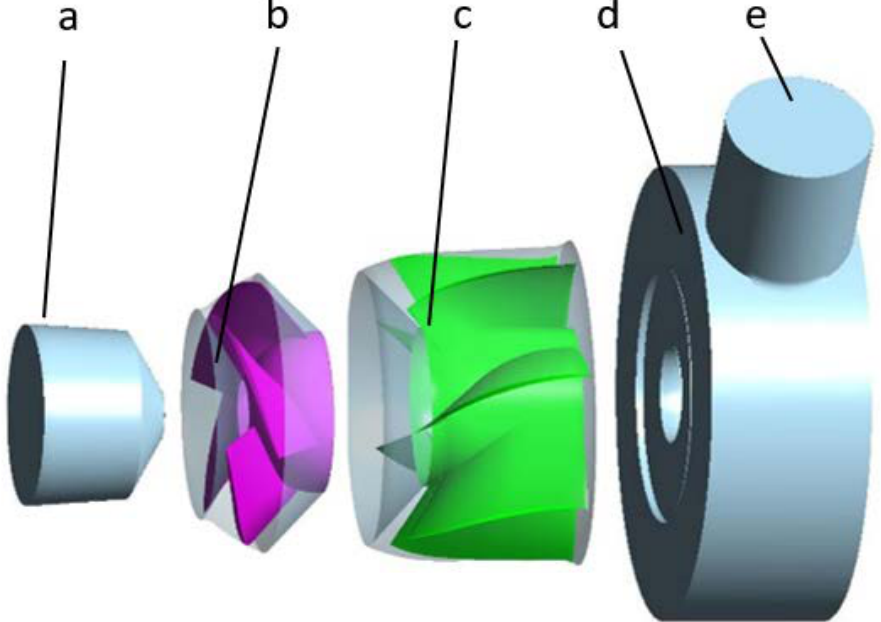
Figure 1. Mixed-flow pump model. ( a ) Inlet Section; ( b ) Impeller Section; ( c ) Guide vane Section; ( d ) Annular cochlear chamber; ( e ) Outlet